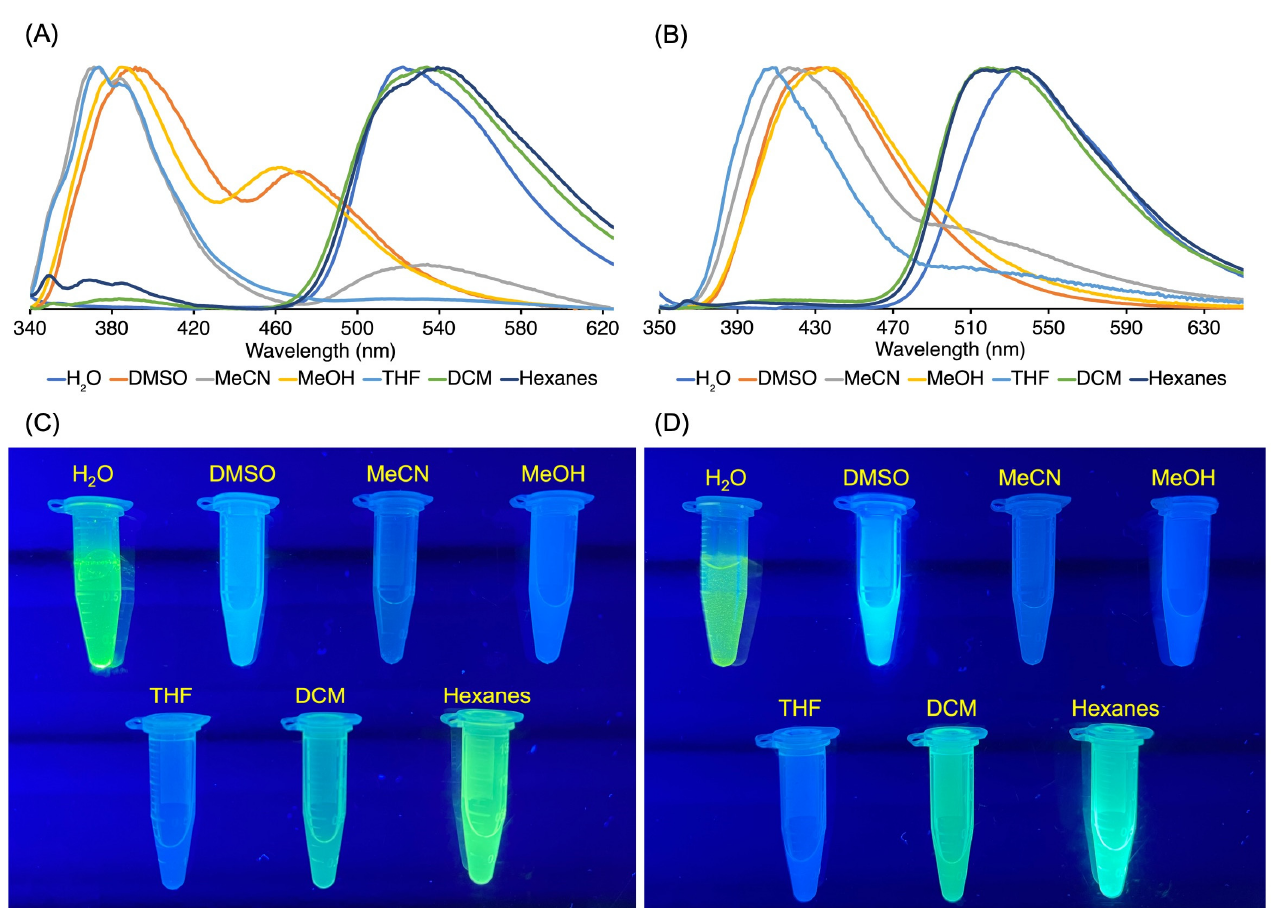
Figure A2. ( A ) Emission spectra (normalized) of 14 (20 μ M ) in various solvents at room temperature ( λ exc = 318 nm). ( B ) Emission spectra (normalized) of 15 (20 μ M ) in various solvents at room temper- ature ( λ exc = 330 nm). ( C ) Visualization (UV illumination) of 14 (20 μ M) in various solvents at room temperature. ( D ) Visualization (UV illumination) of 15 (20 μ M) in various solvents at room temper- ature.